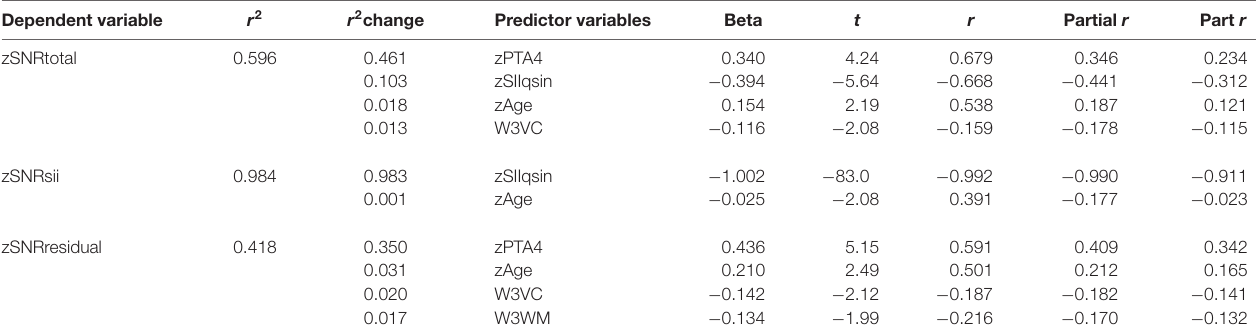
TABLE 2 | The results of the linear regression analyses for the z -transformed QuickSIN SNR components at SRT. Dependent